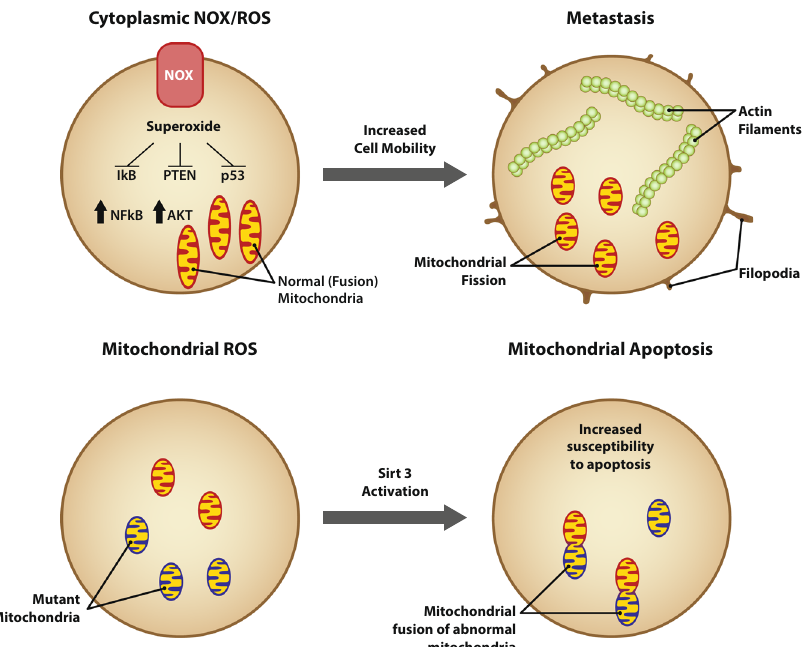
Fig. 2 Signaling in primary tumor and metastasis based upon mitochondrial bioenergetic pro fi le. Large primary tumors express high levels of PCG1 α in a component of their cells. Respiratory cells have both motile and non-motile components. Non-motile components have increased susceptibility to chemotherapy and radiation and represent, in part, the initial population that responds to chemotherapy and radiation. After maximal response, a glycolytic slow growing population is left behind, as well as motile respiratory cells that give rise to metastasis. These metastatic cells may maintain respiration through elevated levels of ClpXP. Once metastatic cells reach a niche, they can reform a mixed population of respiratory and glycolytic cells. Acknowledgement and credit to Brian C. Brockway, M.S., Medical Media, Atlanta VA